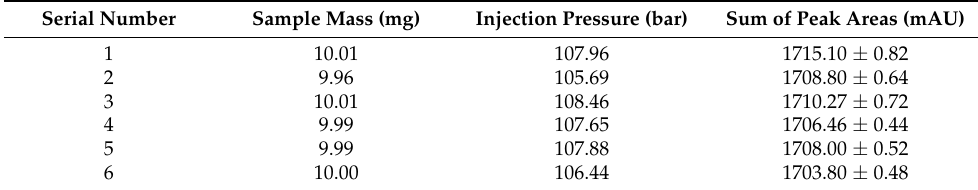
Table 3. Repeatability experimental data.